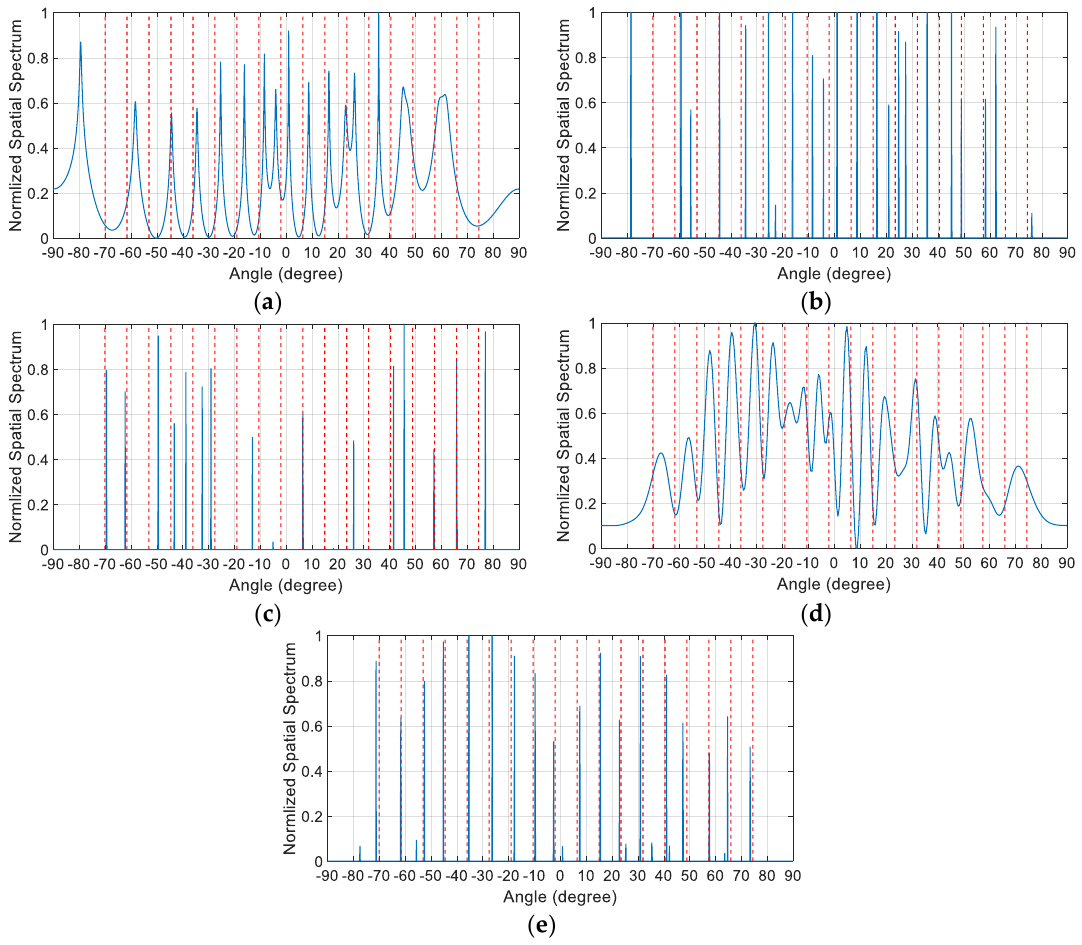
Figure 6. Normalized spatial spectrum comparison with SNR = 30 dB and the number of snapshots T = 2000 when K = 18 and M = { 4,8 } . ( a ) NNM algorithm; ( b ) SSR algorithm; ( c ) SBAC algorithm